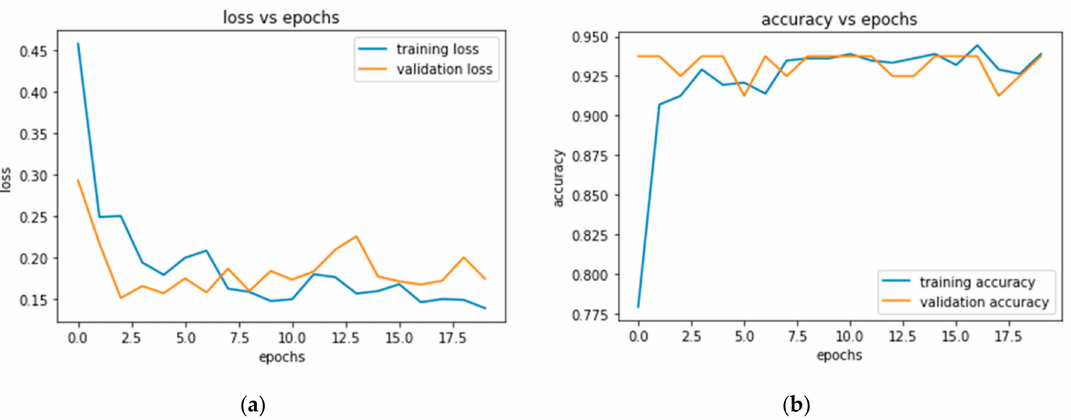
Figure 10. The time series analysis of proposed BiGR is represented as: ( a ) the time series analysis of proposed BiGR among the training loss and validation loss; ( b ) the time series analysis of proposed BiGR among the training accuracy and validation accuracy.